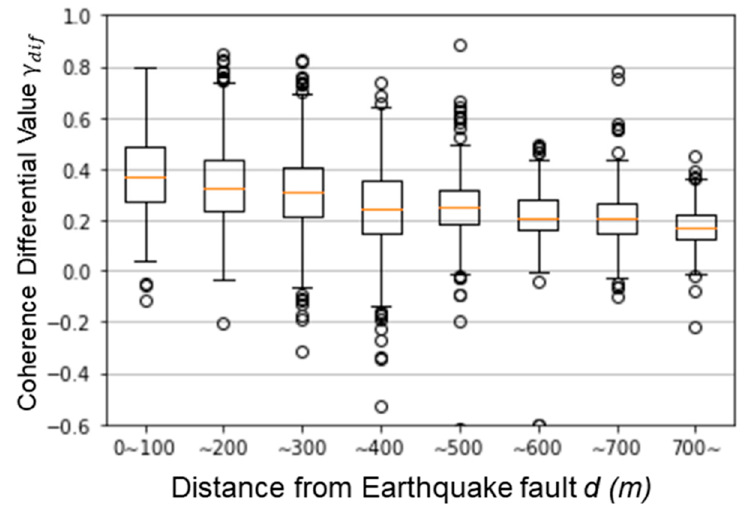
Figure 8. Relationship between the distance from the fault and the coherence differential value γ dif for the buildings categorized as Minor damage.